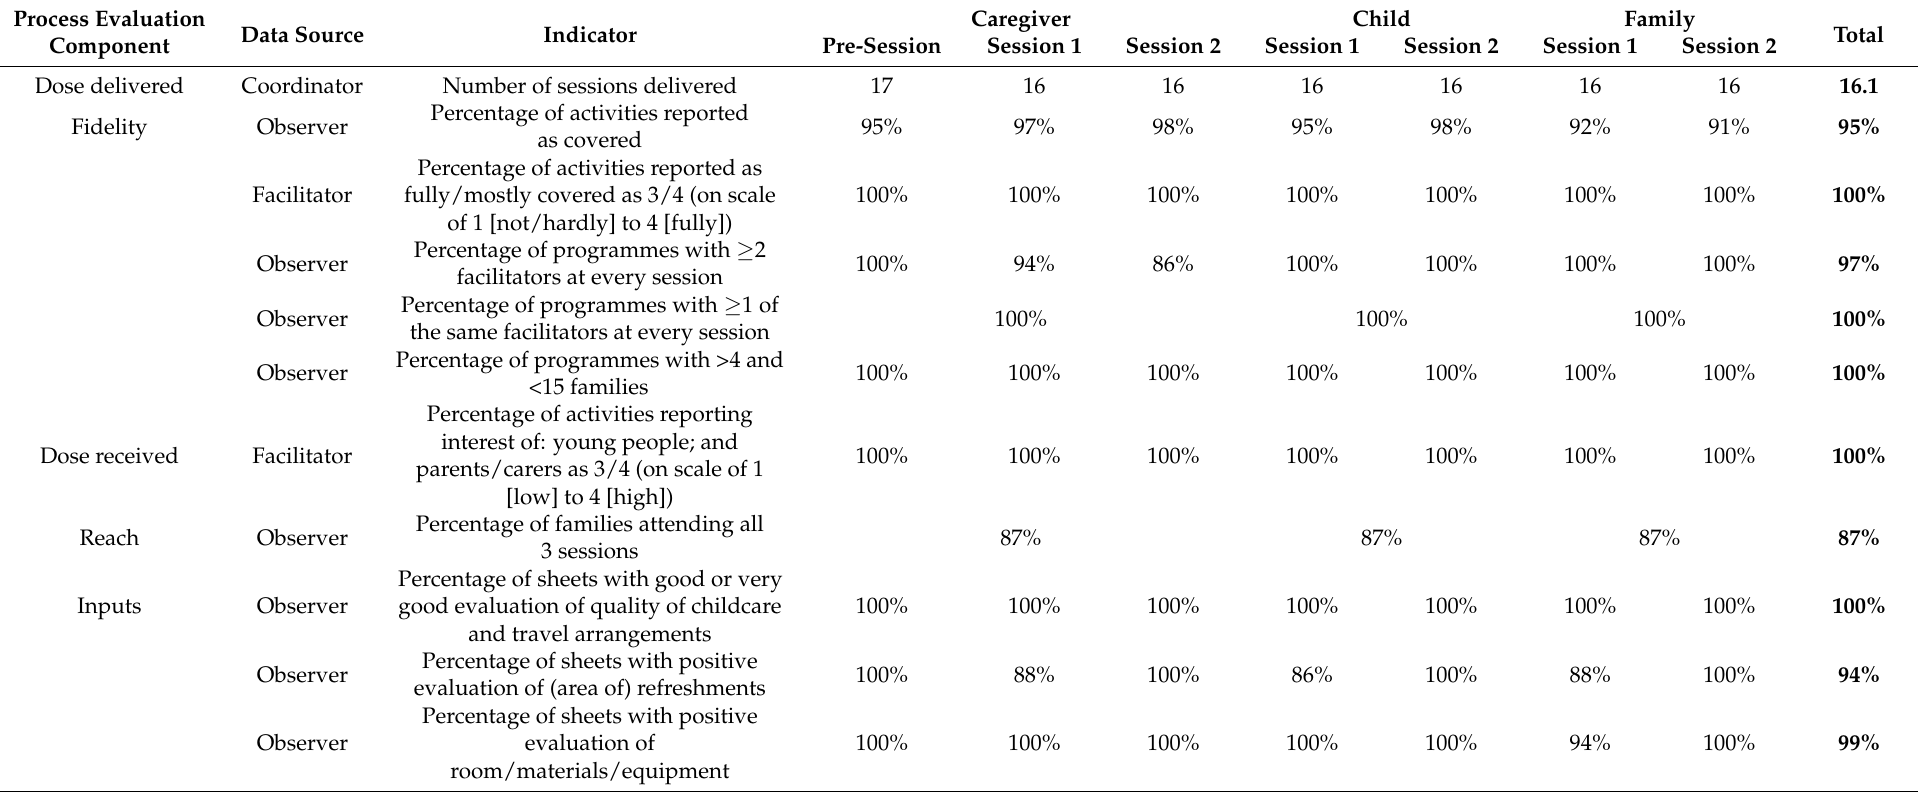
Table A8. Quantitative data sources used to assess implementation of the Strong Families programme, process evaluation components, indicators and performance results. Process